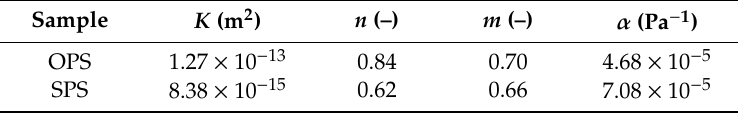
Table 3. Material parameters of samples.